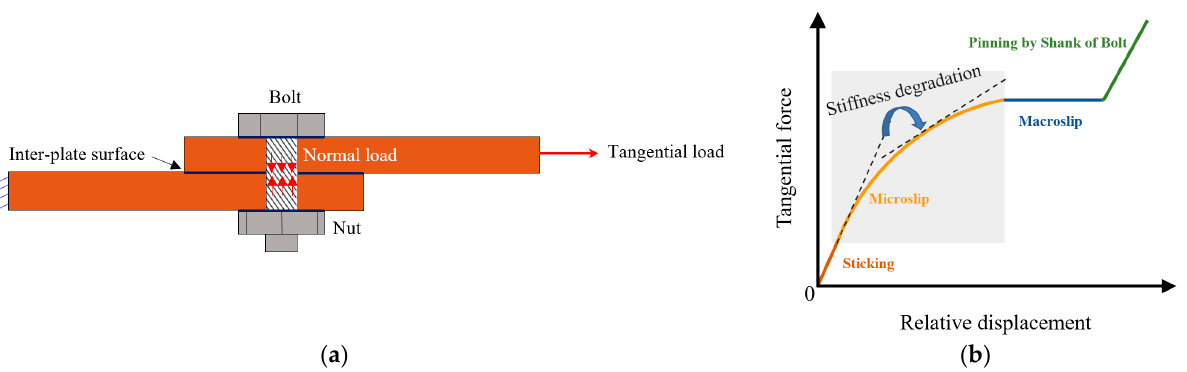
Figure 1. The stiffness degradation of bolted joints: ( a ) bolted joints; ( b ) the stiffness degradation.